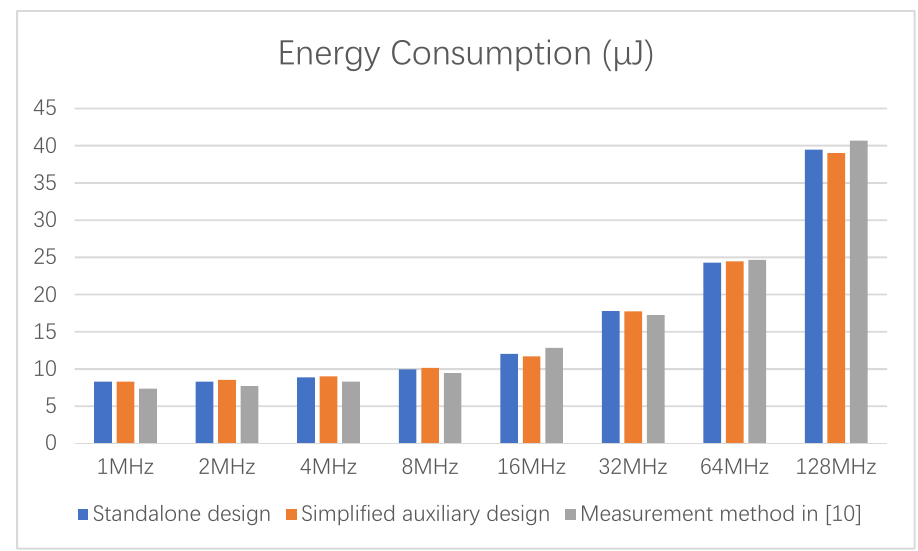
Figure 8. Energy consumption of the STM32F4 processor running at different clock frequencies measured using our designs and the manual measurement.